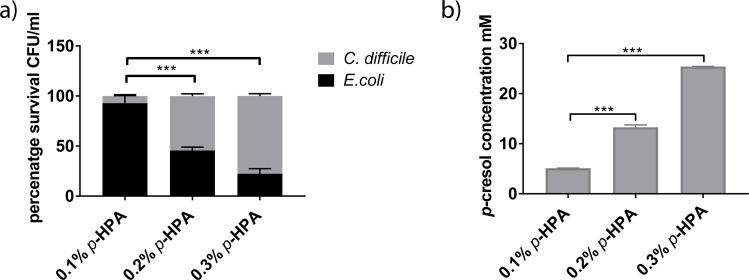
The effect of p-HPA supplementation on competitive co-culture of C. difficile with E. coli and detection of p-cresol production.a) A comparison of the percentage survival of C. difficile strain 630Δerm and E. coli in competitive co-culture for 24 hours, performed in 0.1%, 0.2% and 0.3% p-HPA. Statistical difference in percentage survival was calculated using regression analysis taking strain and media into consideration ***p<0.001. b) HPLC quantification of p-cresol production in competitive co-culture of C. difficile strain 630Δerm with E. coli in media supplemented with 0.1%, 0.2% and 0.3% p-HPA. Statistical difference in p-cresol production was calculated using a two tailed t-test with Welch’s correction, comparing individual p-cresol concentrations to the level produced in 0.1% p-HPA ***p<0.001.